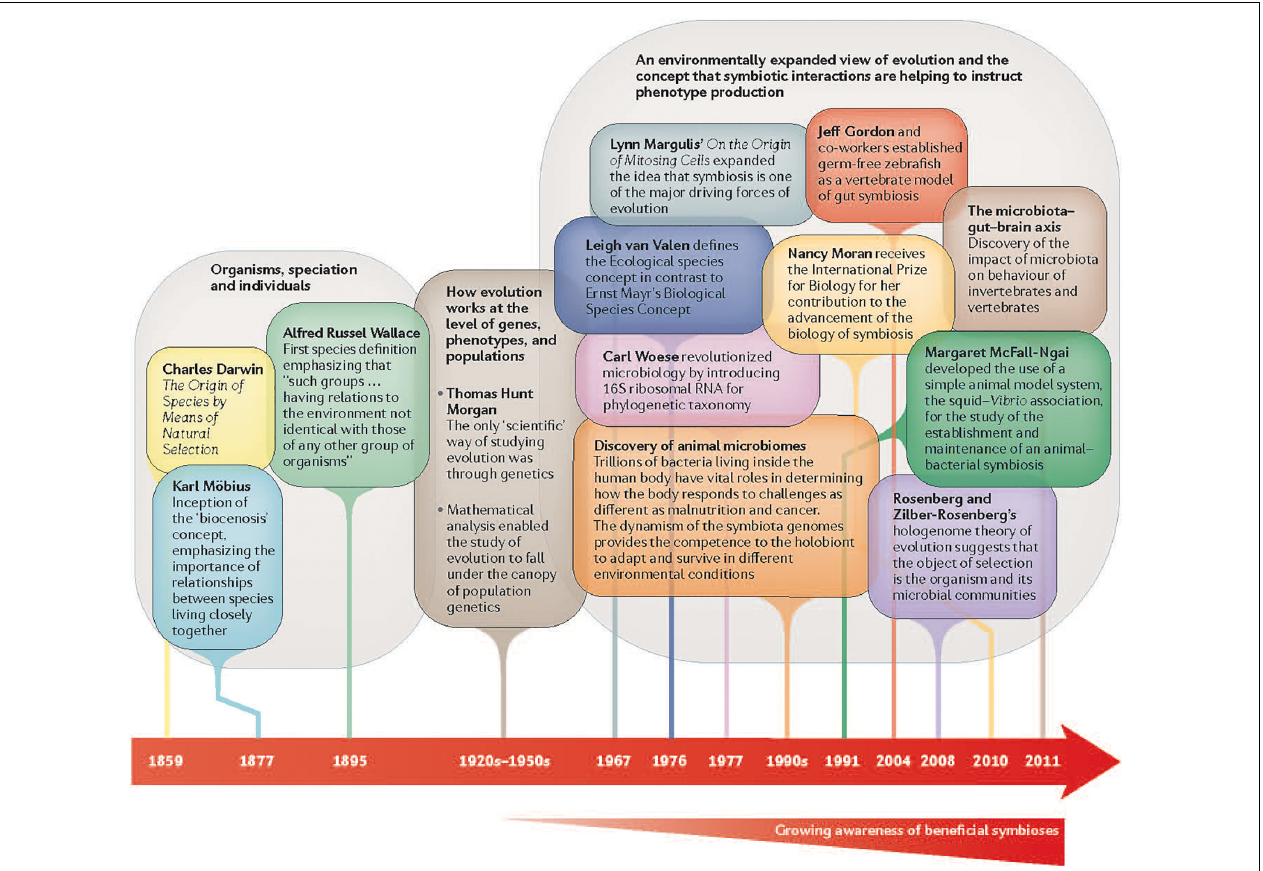
FIGURE 2 | Growing awareness of beneficial symbiosis of organisms to result in an organism’s phenotype. Reprinted with permission from Springer Nature (Gilbert et al.,